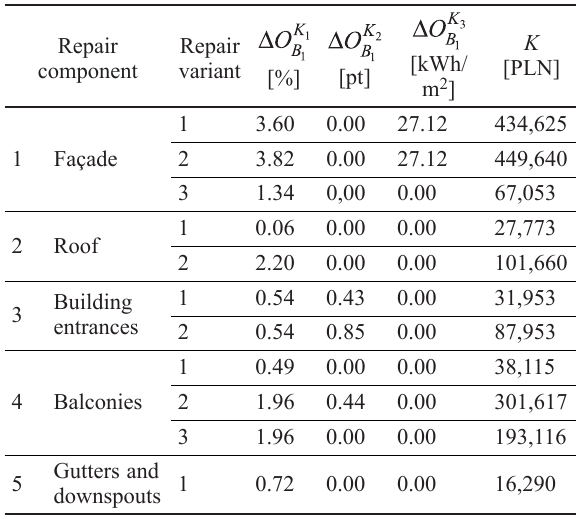
table 5. Sample of repair variants possible for building B 1 (shown 5 out of 13